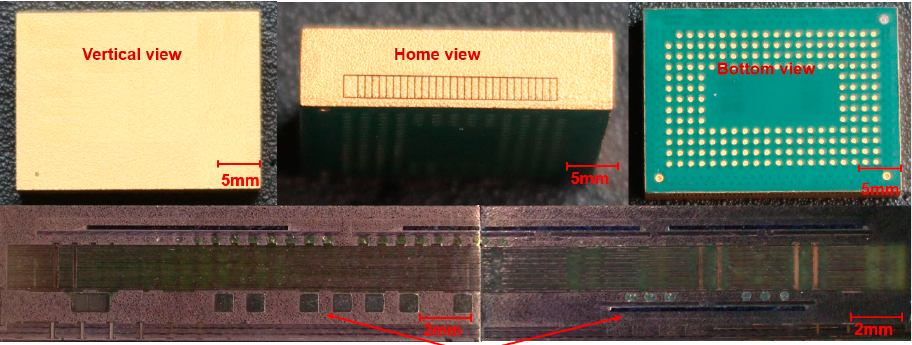
Figure 1. 3D packaging memory device.